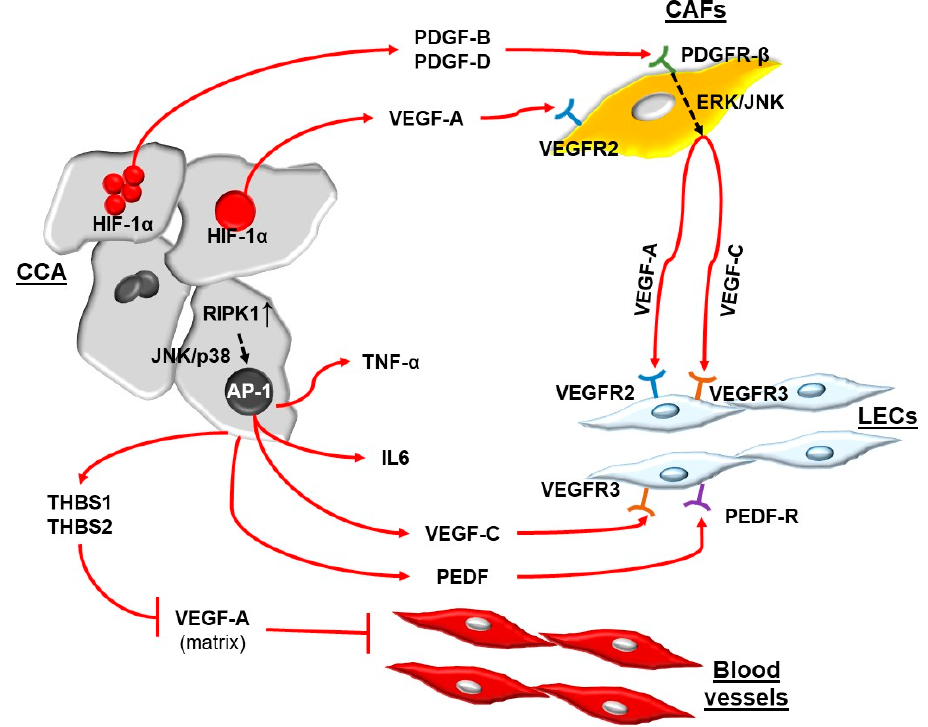
Figure 2. Molecular mechanisms regulating lymphangiogenesis in CCA. The recruitment of the lymphatic plexus in CCA is mediated by the coordinated action of neoplastic cells and stromal cells hosted in the tumor microenvironment. Tumor cholangiocytes (CCA), in response to a hypoxic stimulus, upregulate HIF-1 α , which is responsible for the increased secretion of VEGF-A, PDGF-B, and PDGF-D. These mediators recruit CAFs, which in turn are induced to secrete VEGF-A and VEGF-C via an ERK/JNK-mediated pathway, ultimately responsible for the vascular assembly of LECs. CCA cells are also able to directly recruit LECs through a RIPK1/p38/JNK/AP-1-mediated pathway that stimulates VEGF-C and PEDF hypersecretion. This same pathway is also able to stimulate the secretion of proinflammatory cytokines such as TNF- α and IL-6, with effects on the inflammatory milieu of the tumor microenvironment. Finally, the secretion of THBS1 and THBS2 by CCA cells, which inhibit the release of VEGF-A by the other components of the tumor microenvironment (matrix), dampens tumor blood angiogenesis in CCA. See the main text for further description of the mechanisms involved. CCA, cholangiocarcinoma; TME, tumor microenvironment; Hif-1 α , hypoxia-inducible factor-1 α ; VEGF, vascular endothelial growth factor; PDGF, platelet-derived growth factor; CAFs, cancer-associated fibroblasts; ERK, extracellular signal-regulated kinase; JNK, c-Jun N-terminal kinase; LECs, lymphatic endothelial cells; RIPK1, receptor-interacting protein kinase 1; AP-1, activation protein-1; PEDF, pigment epithelium-derived factor; THBS, thrombospondin. Legend: ↑ , upregulation.